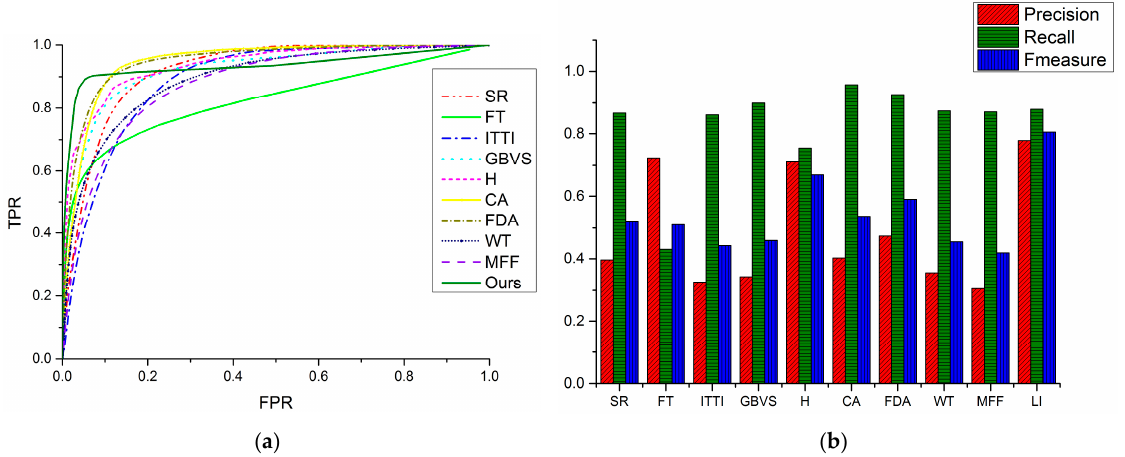
Figure 14. Quantitative comparisons for images polluted by Gaussian noise (Standard Variance = 0.01). ( a ) ROC curves; ( b ) PRF values.